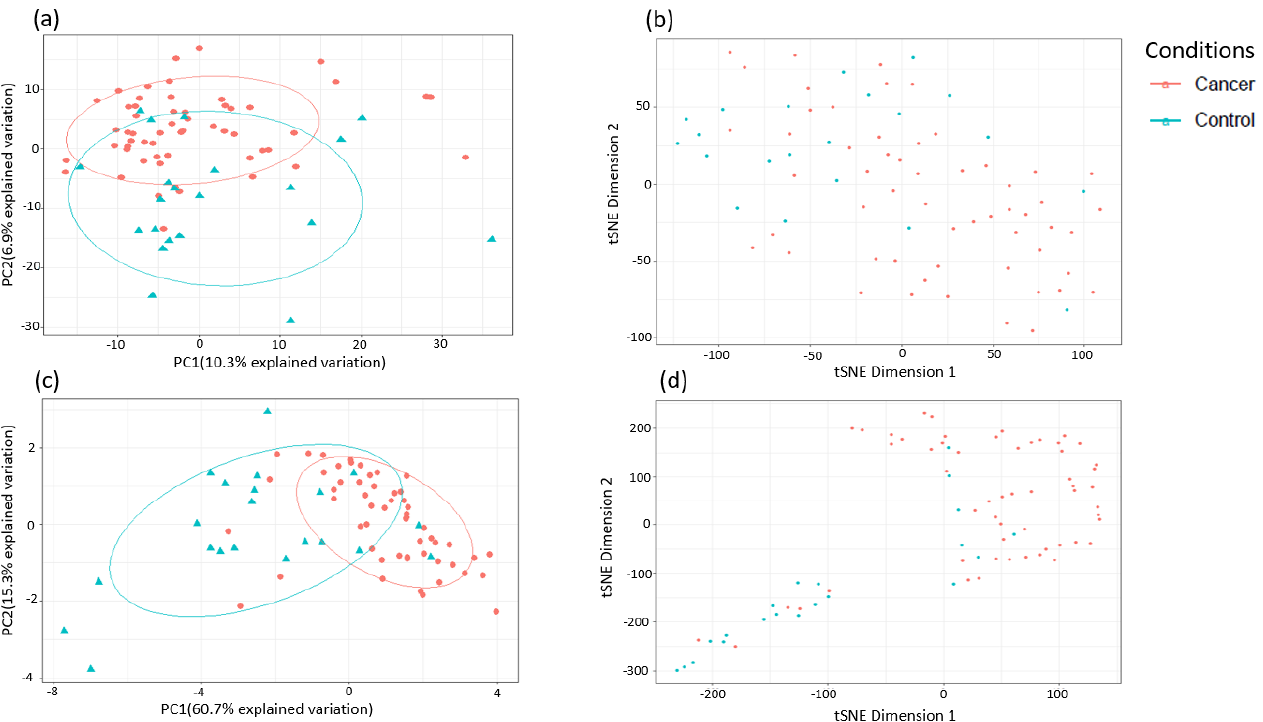
Figure 16. Analysis of sample separation for post-menopausal women ( n = 77, cases = 56, controls = 21) based on PCA ( a , c ) and t-distributed stochastic neighbour embedding (t-SNE) ( b , d ) analyses using all identified metabolites ( a , b ) and the top 10 discriminatory metabolites ( c , d ) identified by random forest machine learning. t-SNE (perplexity: 5, iteration: 10000).